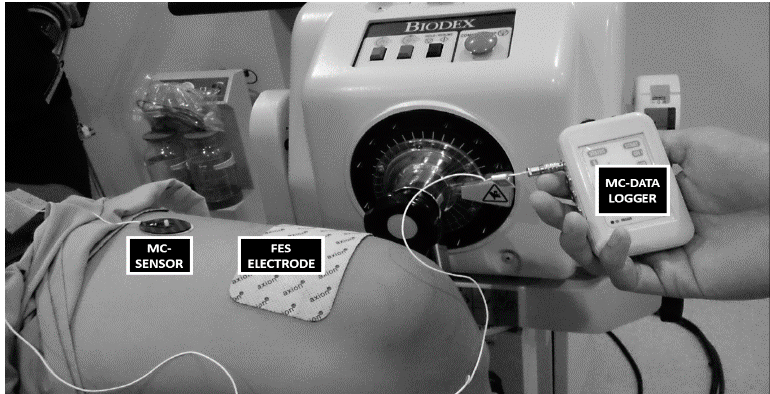
Figure 1. Instrumentation during FES-evoked muscle contractions using MC sensor with the angle of the knee joint set to 30° on Biodex Dynamometer.